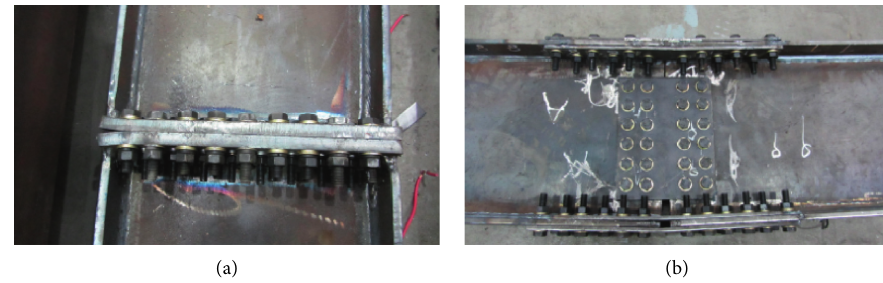
Figure 7: Typical failure mode of specimens under midspan load. (a) FLB-1-S2. (b)